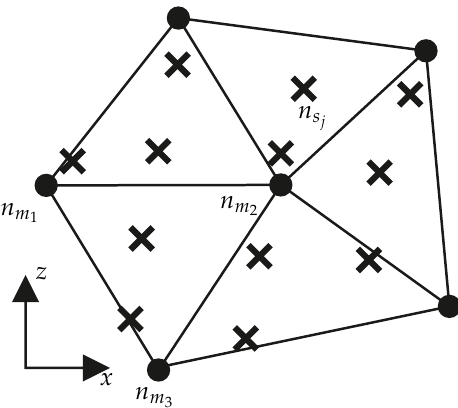
Figure 11. The position of the master node n m In addition, the position of all slave nodes which are located at time t i + 1 on areas connected to n m